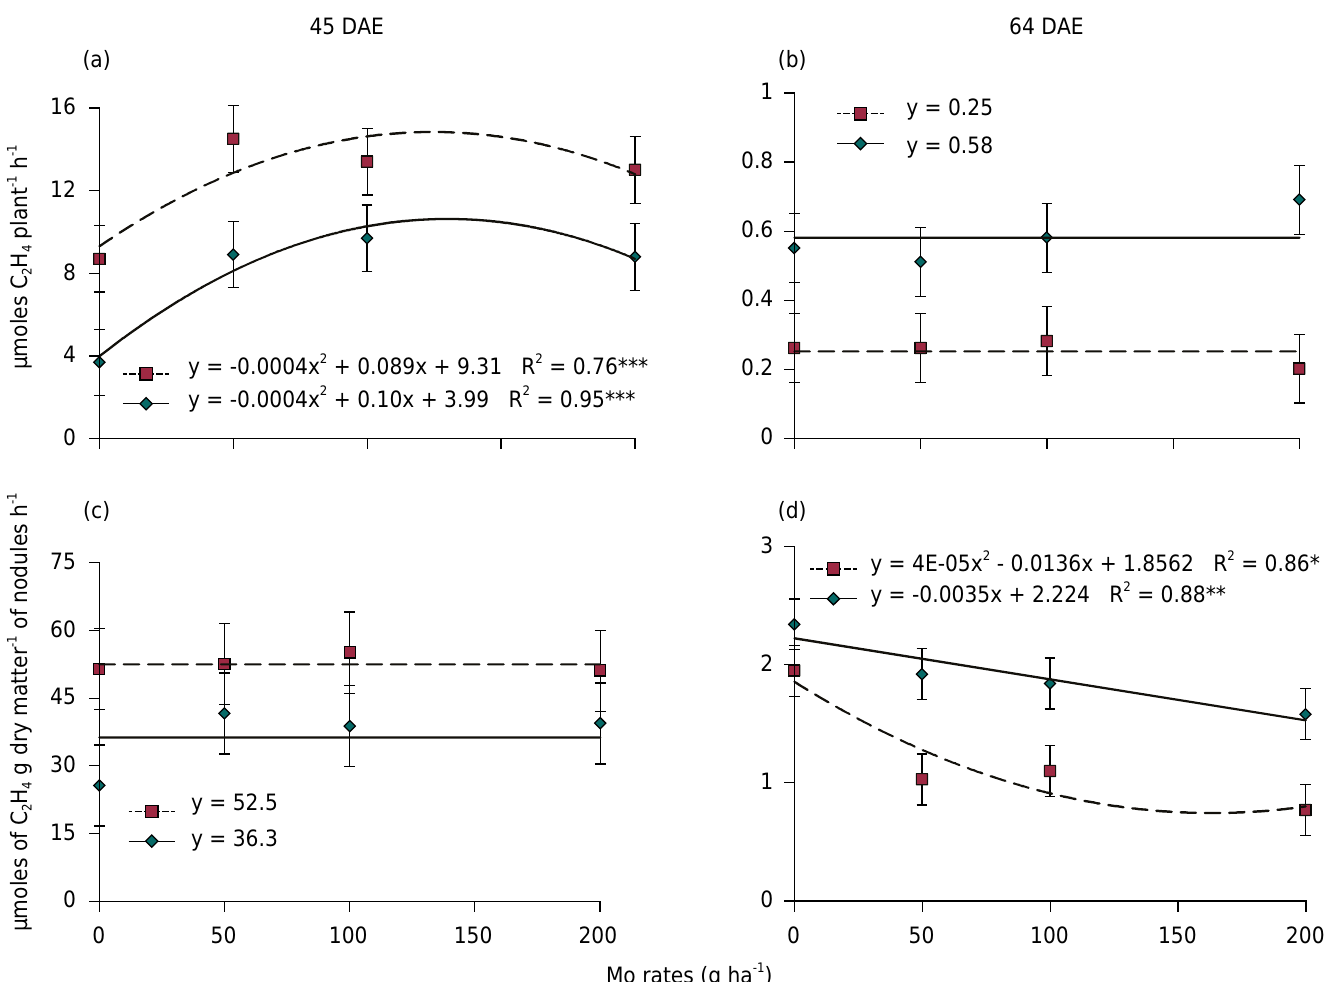
Figure 2. Nitrogenase enzyme activity (a and b) and nitrogenase specific activity (c and d) as a function of Mo rate and rhizobial inoculation [without (□) and with (♦) inoculation] at two different stages of peanut growth (45 and 64 days after emergence, DAE). ***, **, and * are significant at p<0.01, p<0.05, and p<0.10, respectively.